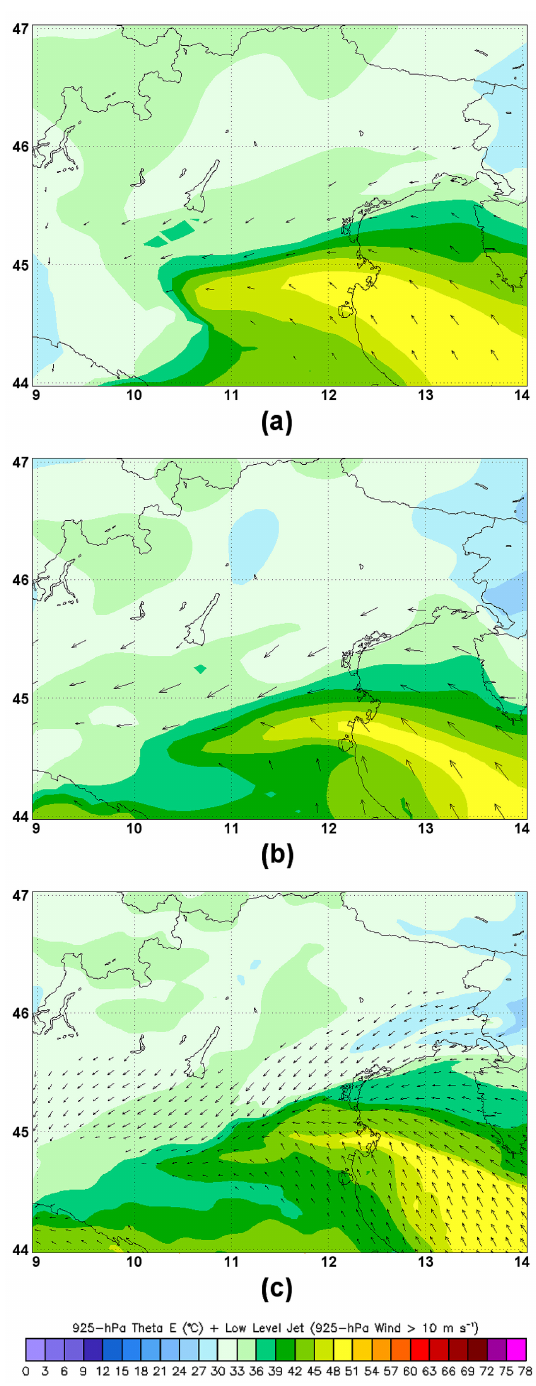
Figure 11. Contour plot of the 925hPa ( θ e ) forecast at 21:00UTC of 31 October 2012 over the NEI hydrometeorological site and the low-level jet forecast for the 0.1 ◦ BOLAM from the oper- ational SIMM (a) , and the 0.07 ◦ BOLAM (b) and the 0.0225 ◦ MOLOCH (c) from the HyMeX SIMM. The forecasts were ini- tialised at 12:00UTC of 30